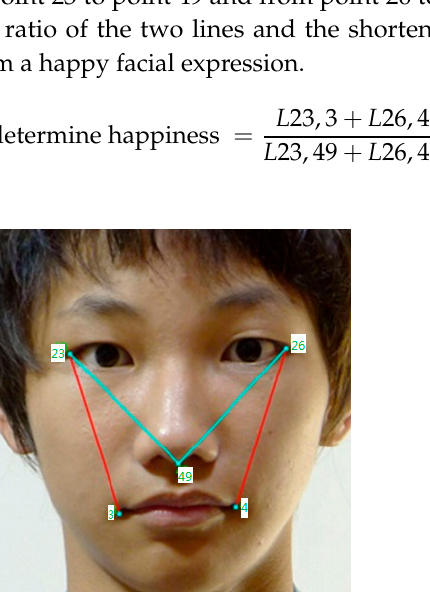
Figure 3. Four reference lines to determine happiness.